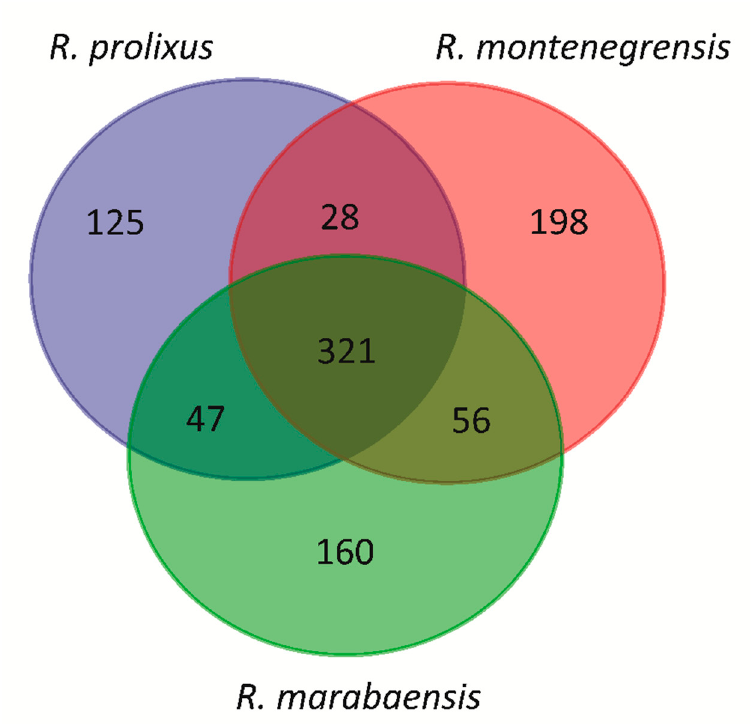
Figure 5. Venn diagram of the distribution of TE families in R. prolixus , R. montenegrensis, and R. marabaensis genomes. Overlapping regions of the Venn diagrams indicate families’ share between the three or two pairs of genomes as well as unique families in each genome.